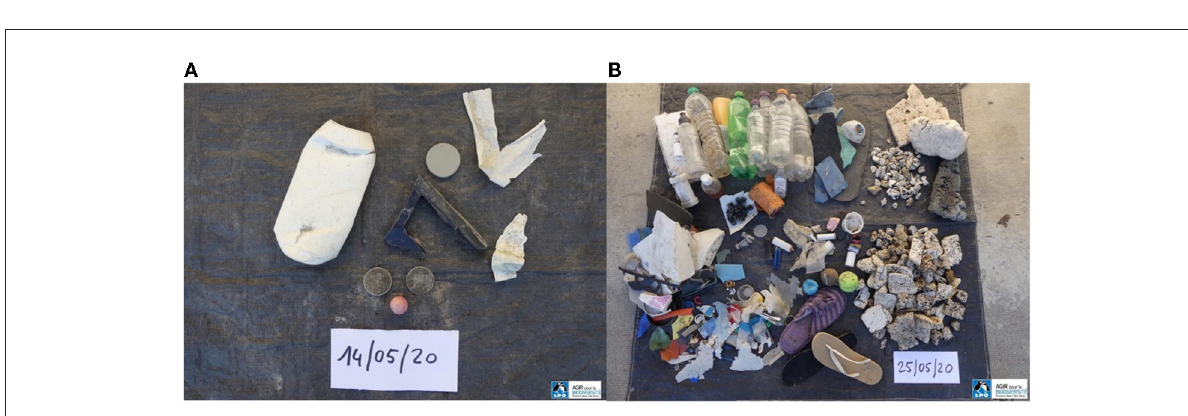
FIGURE6 Items collected on the 100m survey band at S2 before (A) and after (B) of a big river